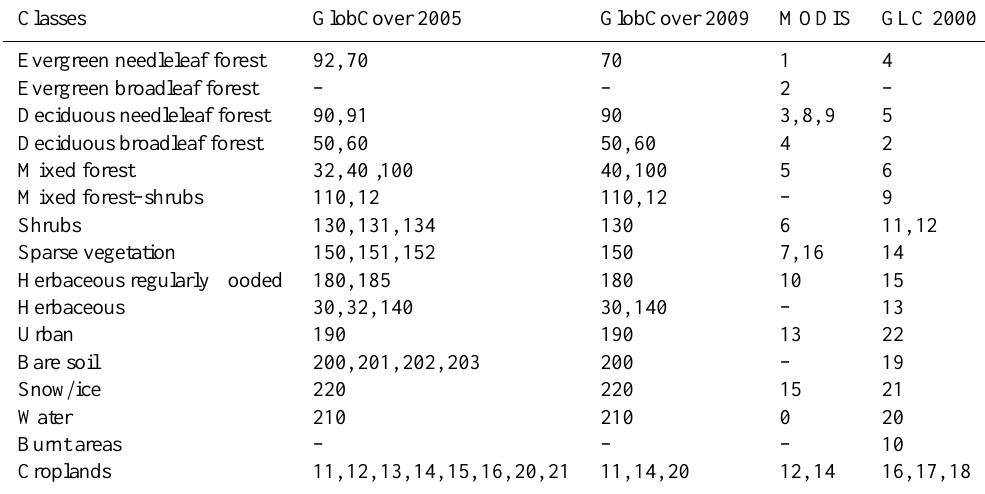
Table 3. Harmonized legend used and correspondence with original product classes. Classes GlobCover 2005 Evergreen needleleaf forest 92, 70 Evergreen broadleaf forest Deciduous needleleaf forest Deciduous broadleaf forest Mixed forest–shrubs Shrubs Sparse